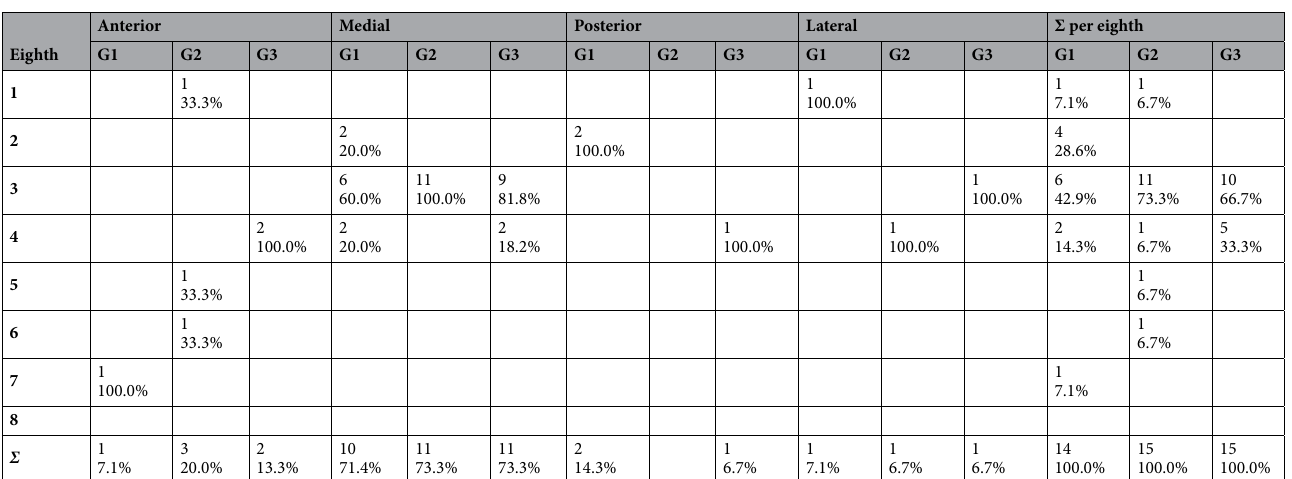
Table 2. Detailed overview of the absolute and corresponding relative frequencies of occurrence of the maximal relative decrease in wall thickness (Max%DecWT) concerning the regions (as defined by the eighths and quarters) among the three study groups G1, G2 and G3. Numbers in the three right columns and the bottom row are sums within each separate eighth (and group) and a quarter (and group),